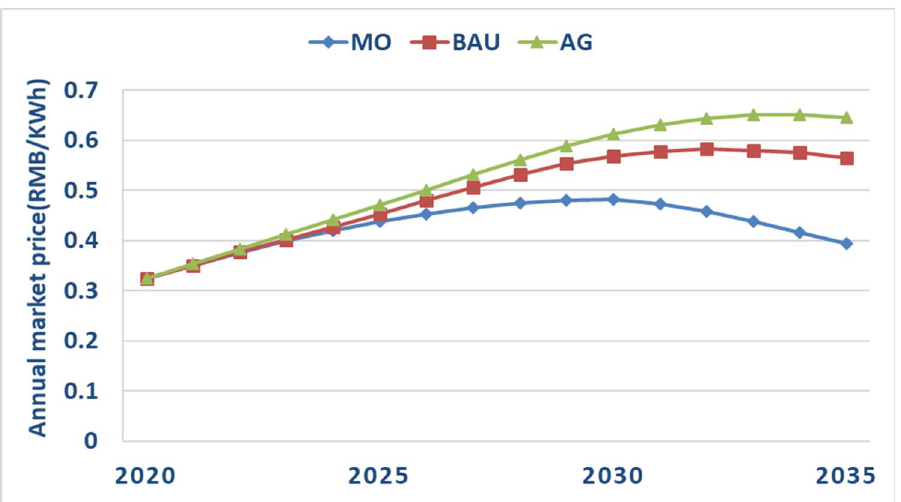
Figure 5. Comparison of the annual average electricity market price over the planning horizon under the MO, BAU and AG electricity marketization scenarios. Table 13. Comparison of the annual operating hours of COAL, GAS and BIGM in the electricity market part under the MO, BAU and AG electricity marketization scenarios.